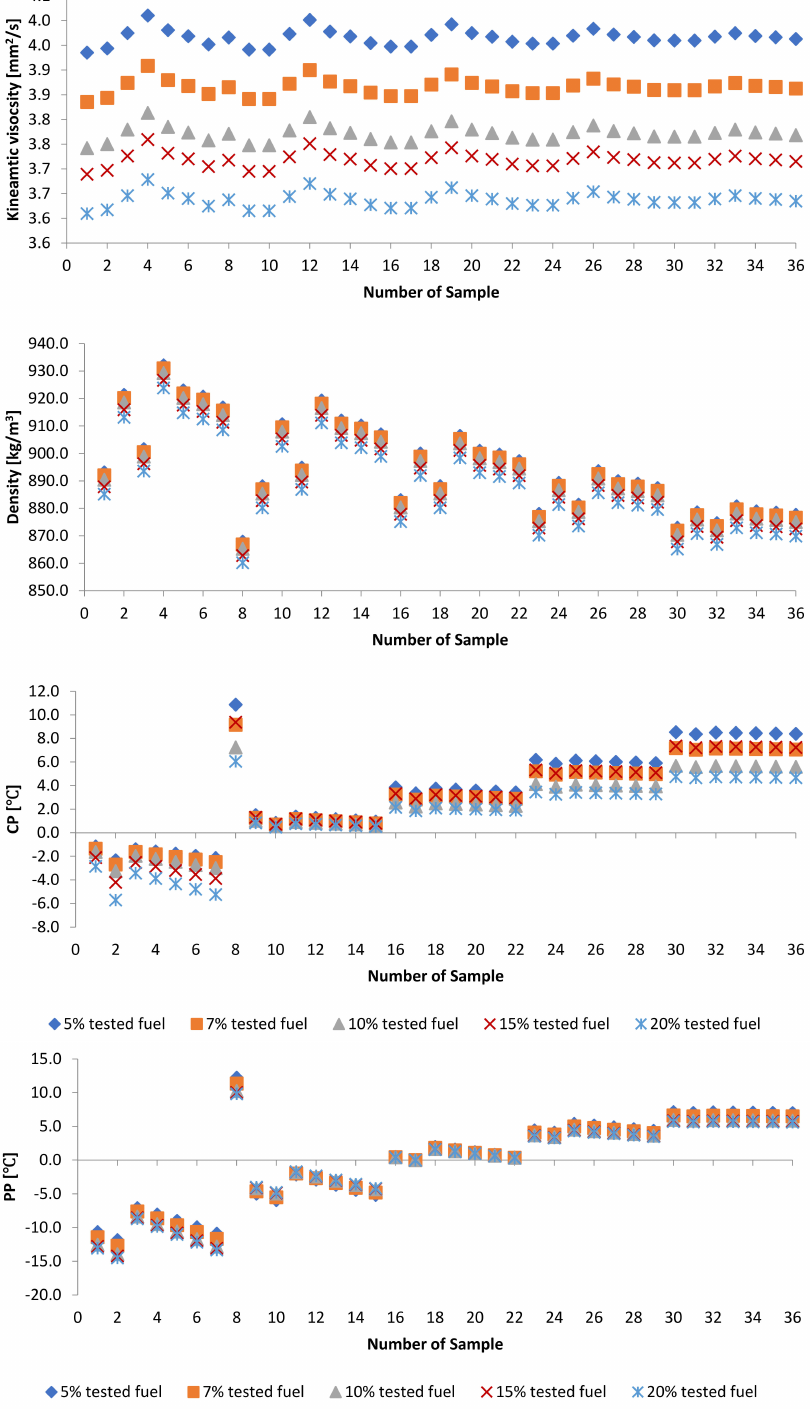
Figure 11. Properties of WFME-PME-ULSDFS with various volume